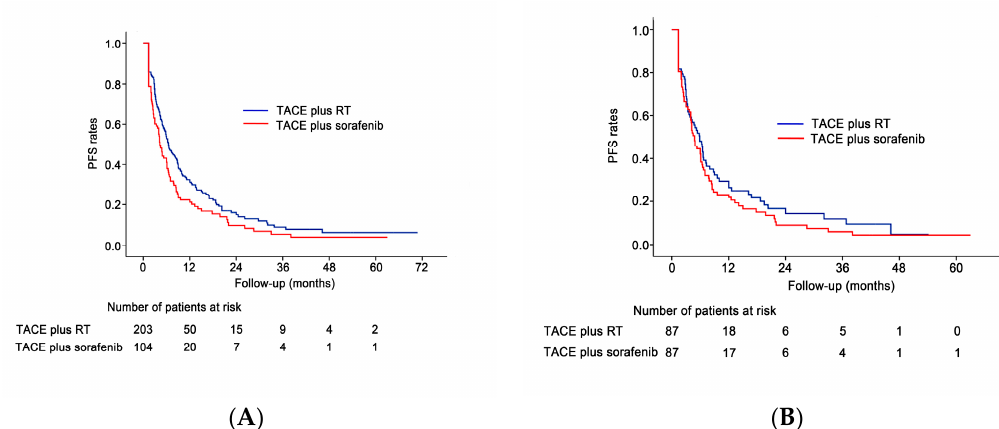
Figure 3. PFS outcomes before and after propensity score matching. ( A ) The PFS rate was significantly higher in the TACE plus RT group than in the TACE plus sorafenib group ( p = 0.017) in the original study cohort. ( B ) The PFS rate did not differ significantly between the two groups ( p = 0.258) in the propensity matched cohort.